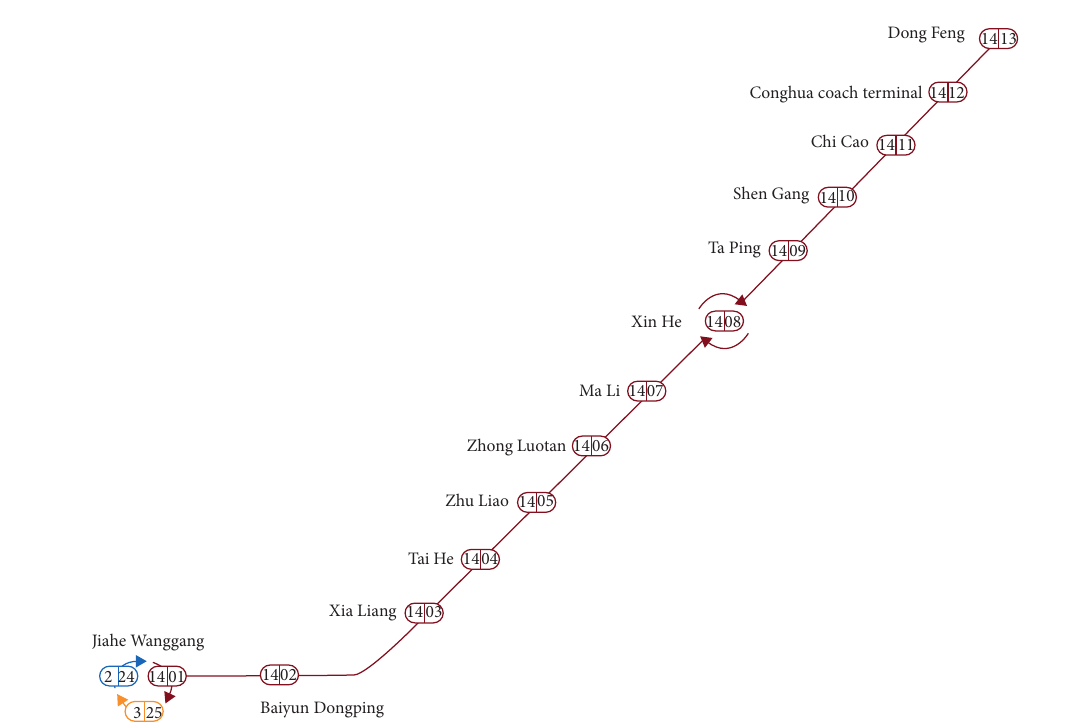
Figure 9: Sketch map of Guangzhou Metro Line 14. Table 3: Train running time between each station.